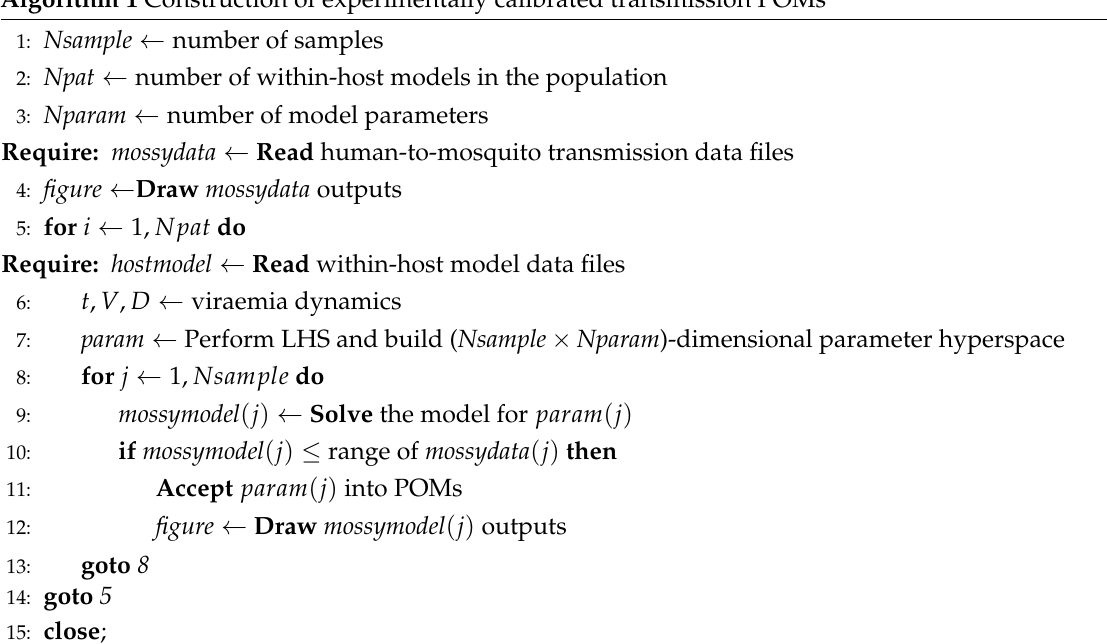
figure ← Draw mossymodel ( j )